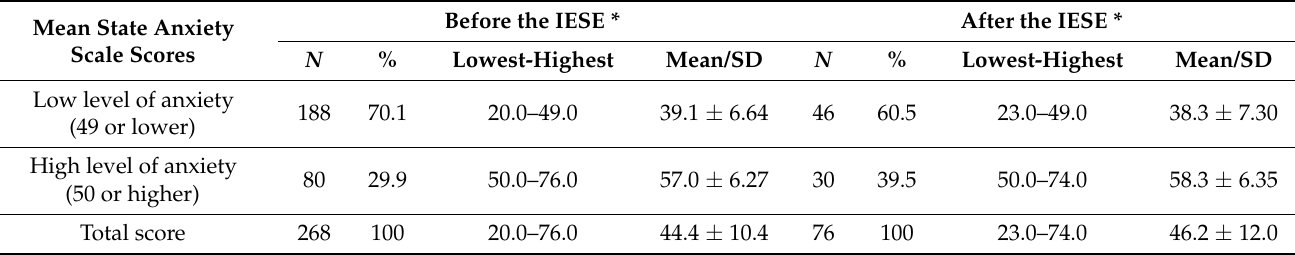
Table 1. The distribution of the students’ mean state anxiety scale